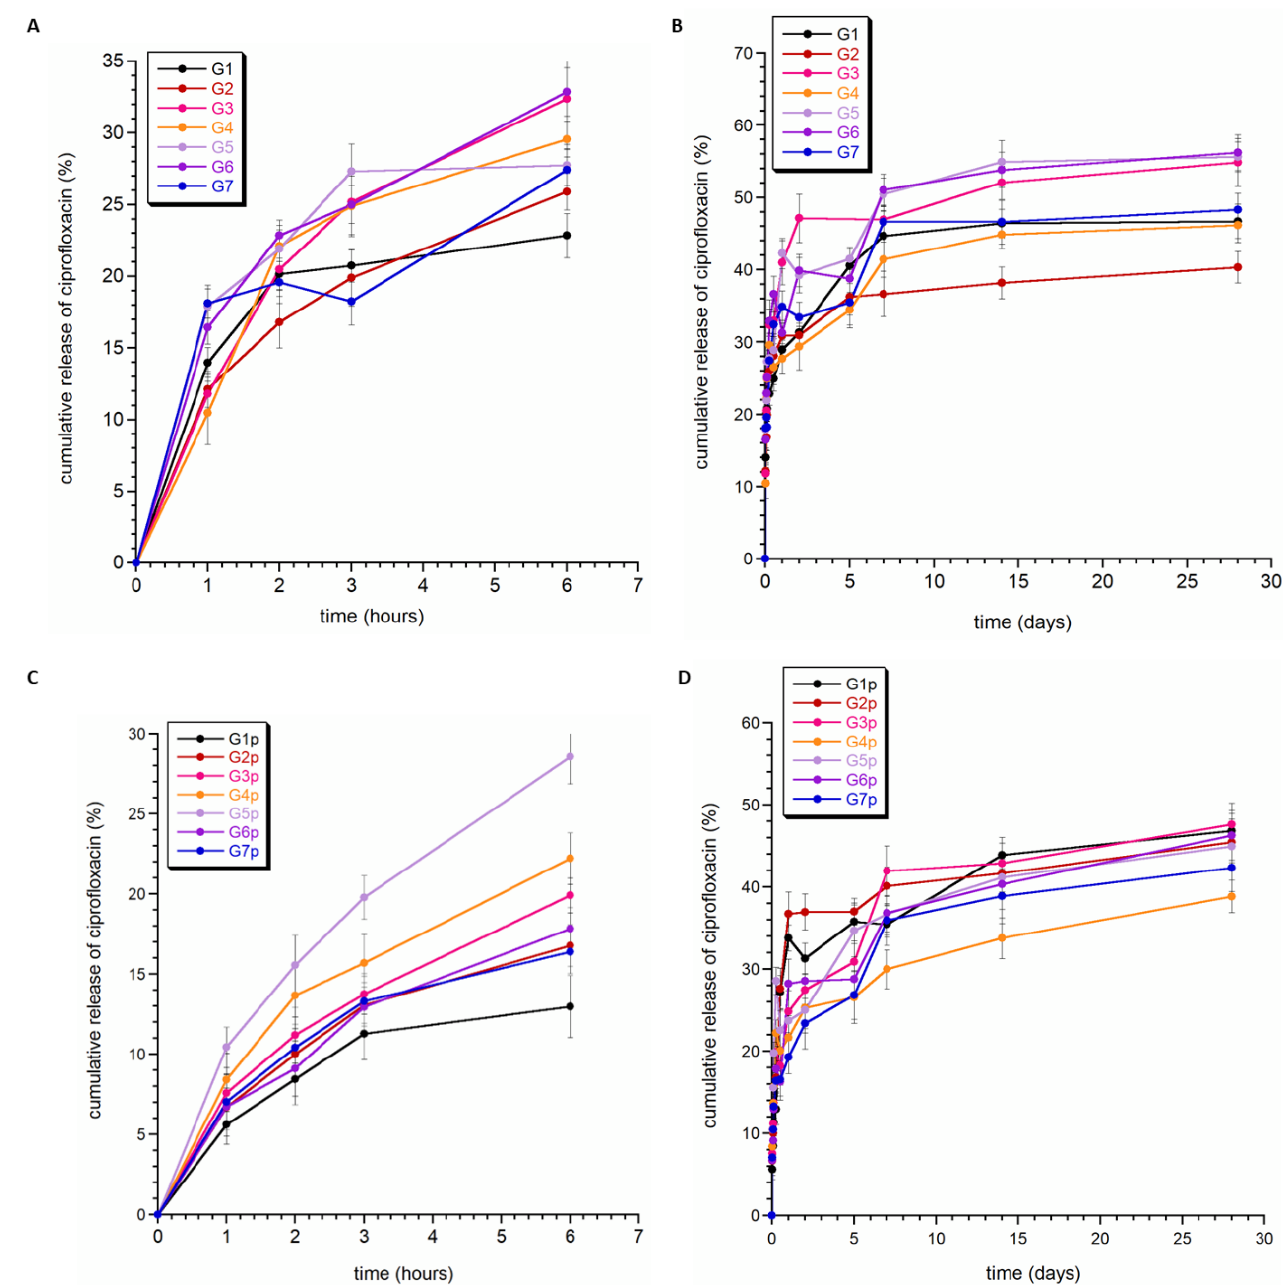
Figure 6. Release profiles of ciprofloxacin from the granules without PCL ( A , B ) and the granules with PCL ( C , D ).